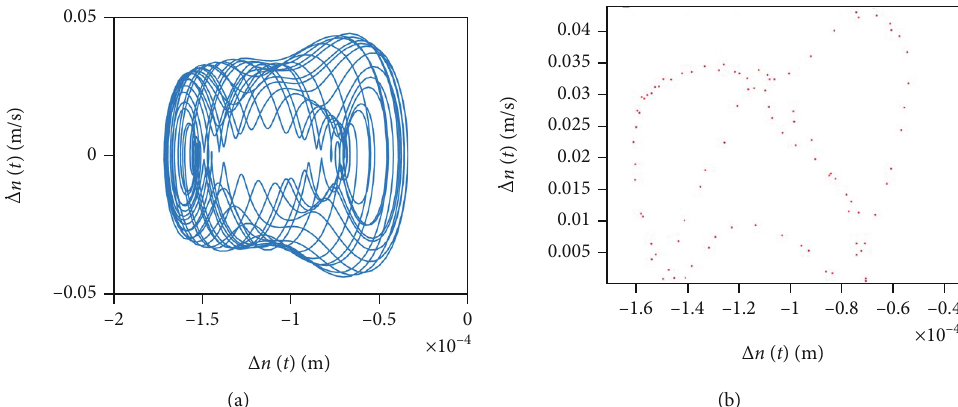
Figure 27: When the rotation speed of the system is 4600r/min: (a) relative displacement velocity and (b) the corresponding diagram of Poincare.